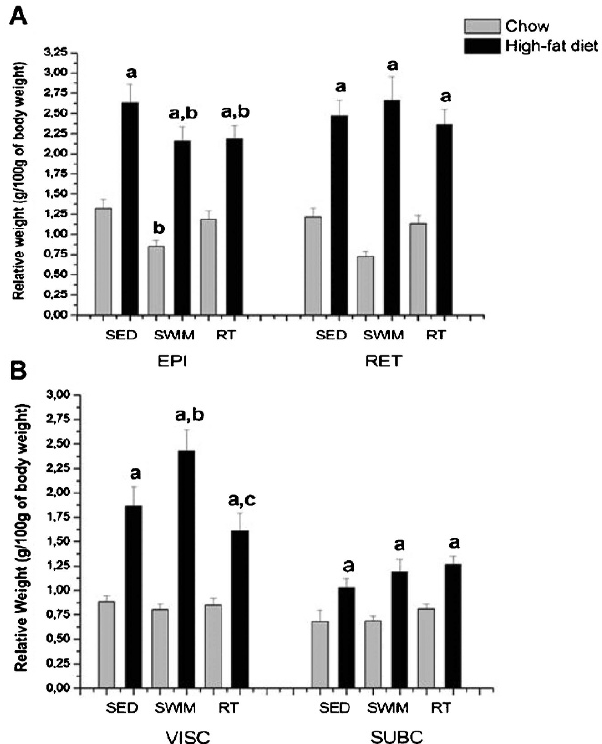
Figure 2 - Relative weight of adipose tissue. All values are presented as means ¡ standard error of the mean; a p # 0.05 comparing normal chow diet vs high-fat diet groups; b p # 0.05 comparing sedentary vs trained groups; c p # 0.05 comparing swimming vs resistance training groups ( n =10 each group). A, EPI, epididymal; RET, retroperitoneal; B, VISC, visceral; SUBC, subcutaneous; SED, sedentary; SWIM, swimming; RT, resistance training.